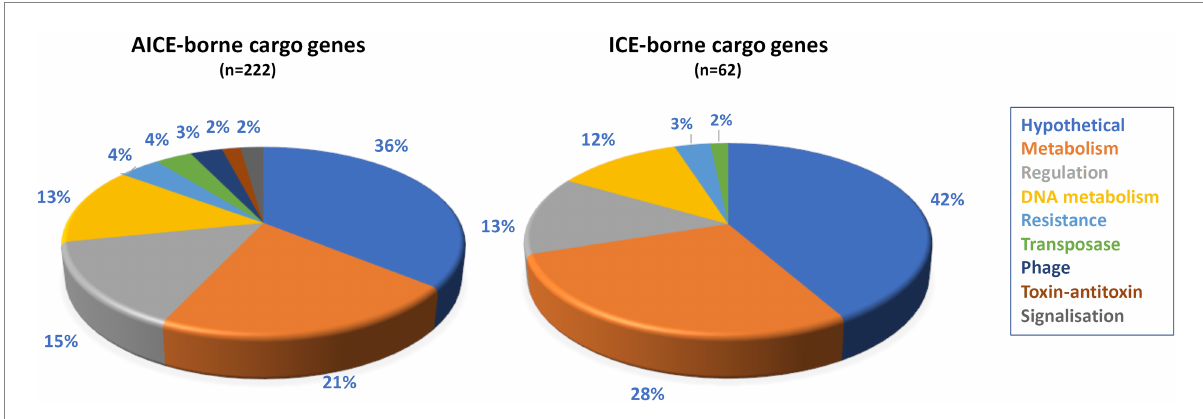
FIGURE 5 Functional distribution of the cargo genes carried by AICEs/ICEs. Cargo genes (protein size threshold >150 amino acids) were assigned to functional categories using BlastP searches ( e -value cut-off 10 − 6 , coverage threshold 80%). The functional categories are indicated by colors whose correspondence is indicated below the figure. BlastP results are presented in Supplementary Tables S7 (AICE), S8